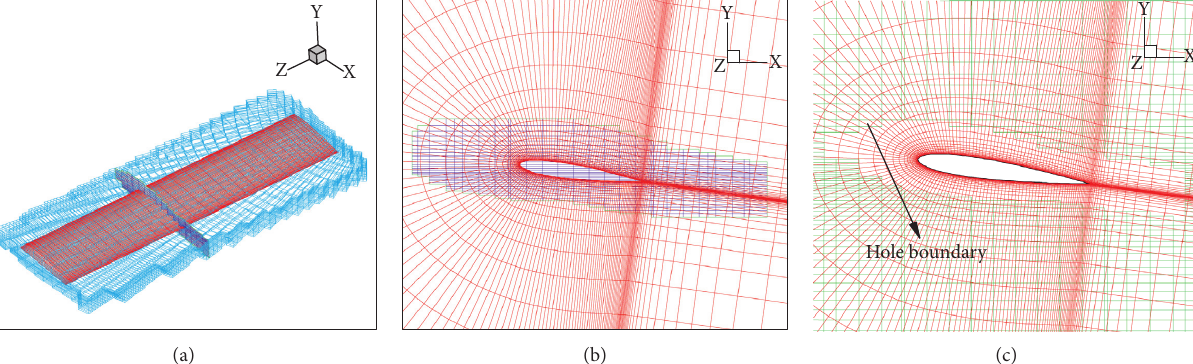
Figure 15: Schematic diagram of artificial inner boundary on the background grid. (a) Hole domain. (b) A section of holeomain. (c) Hole boundary